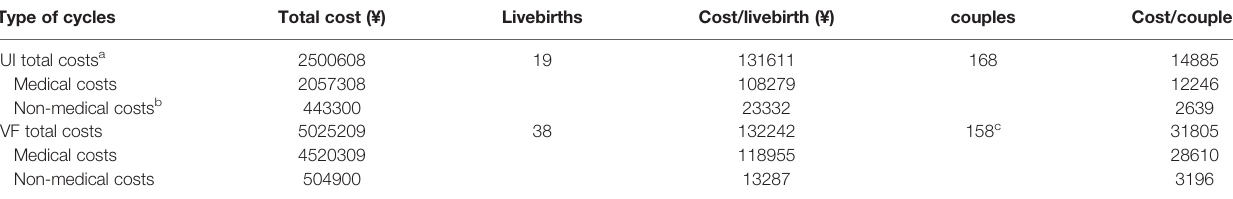
TABLE 7 | Cost-effectiveness analysis.